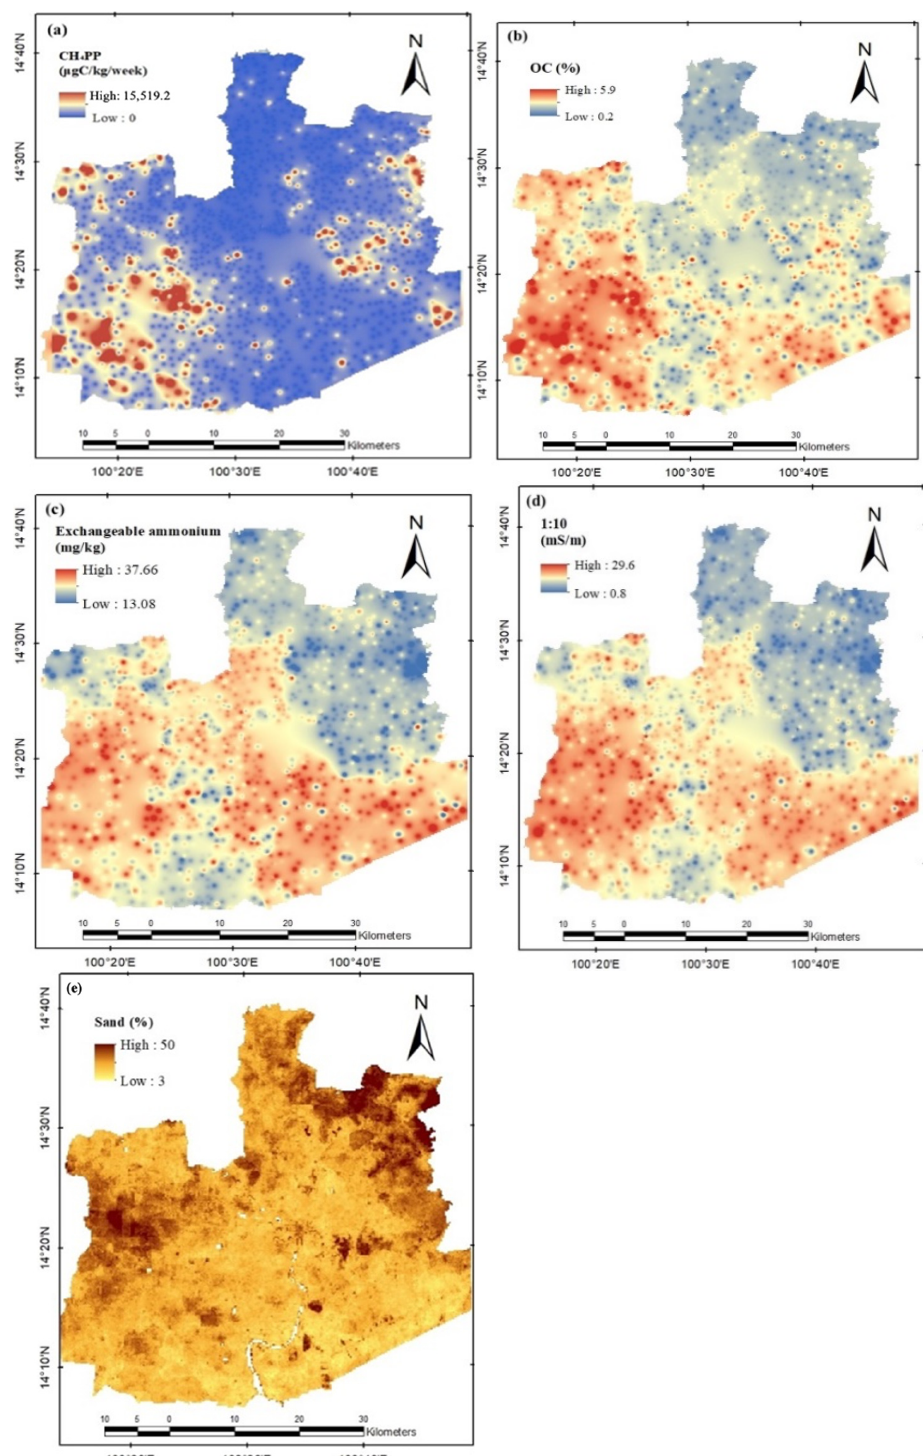
Figure 8. Spatial map of predicted CH 4 production potential ( a ), soil organic carbon ( b ), predicted exchangeable ammonium ( c ), 1:10 predicted electrical conductivity ( d ), and sand content ( e ) in